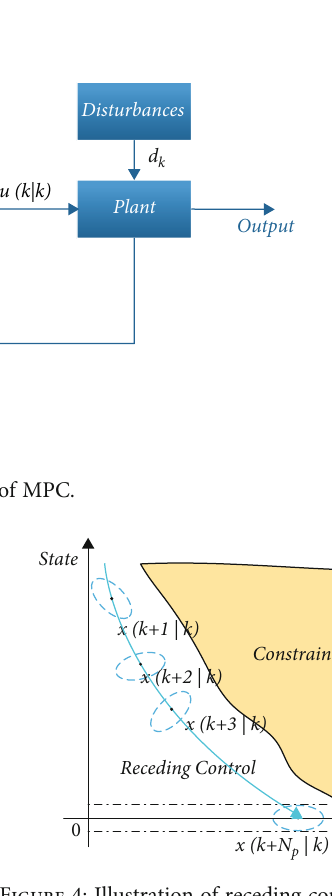
Figure 4: Illustration of receding control